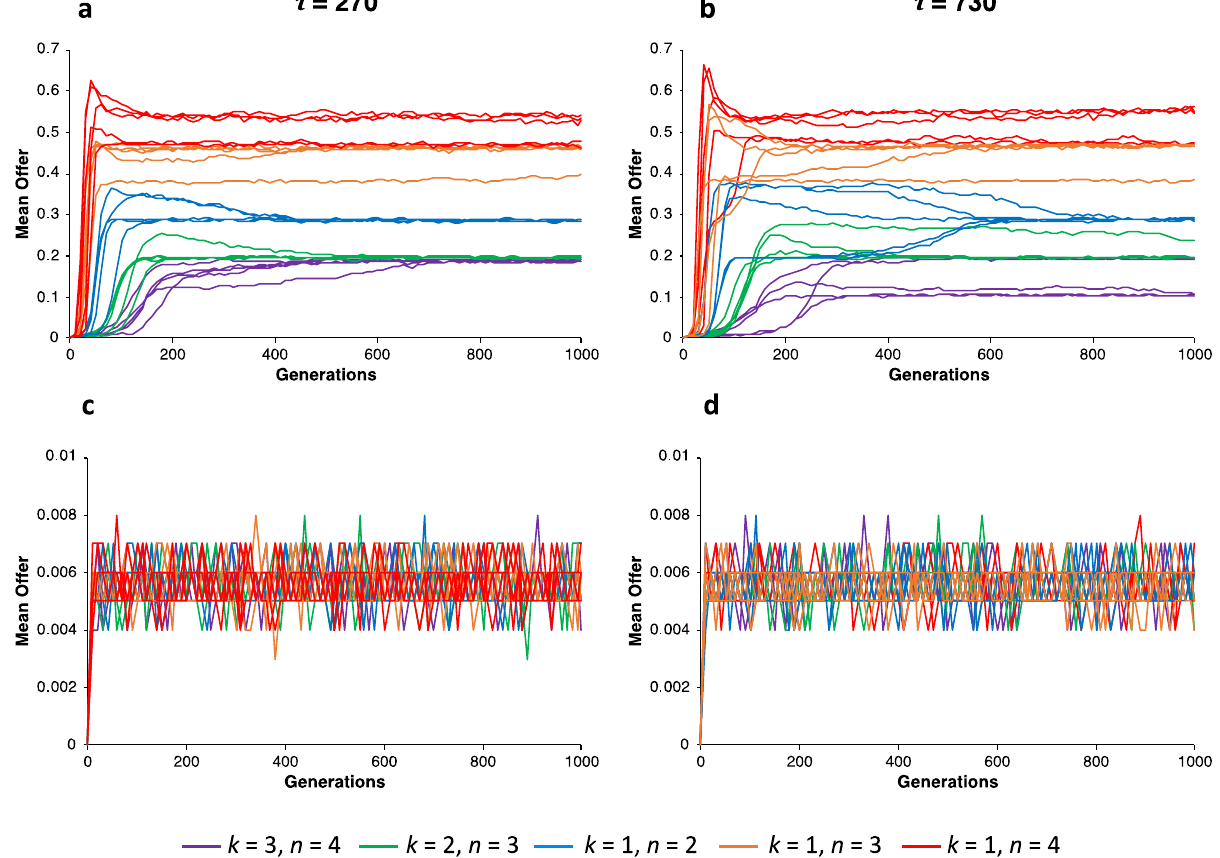
Figure 4. Invasion analysis of equitable offer strategies in group-structured and unstructured populations for γ = 0.9 and c = 0.01. Evolved mean offers in structured populations for τ 0 = 270 ( a ) and τ 0 = 730 ( b ) and for corresponding unstructured populations ( c ) and ( d )